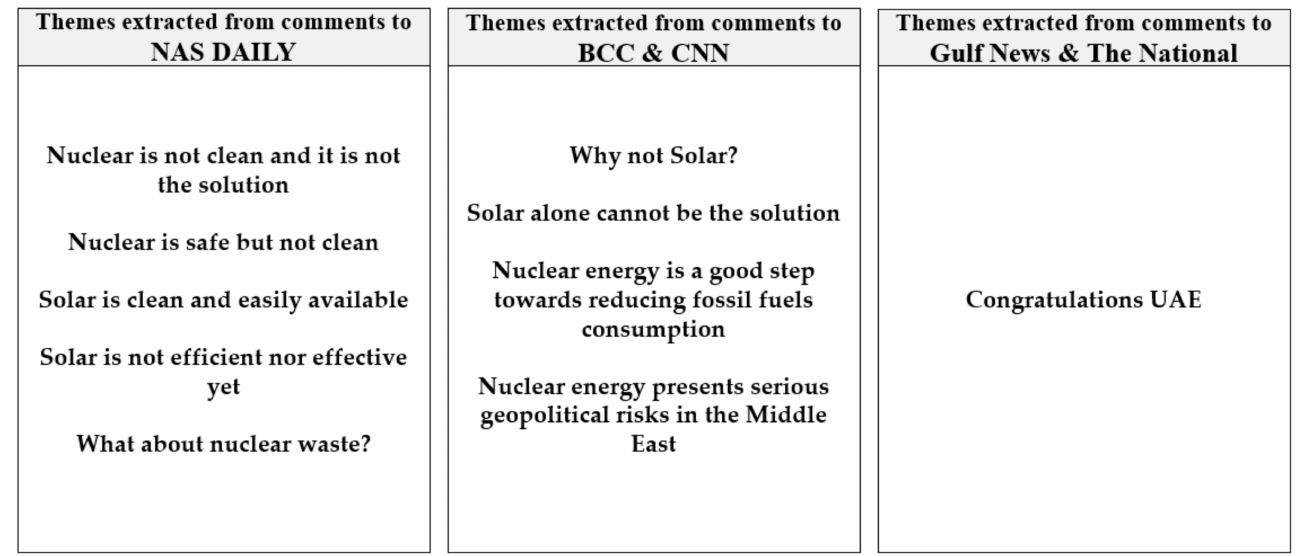
Figure 2. Summary of the main themes identified.